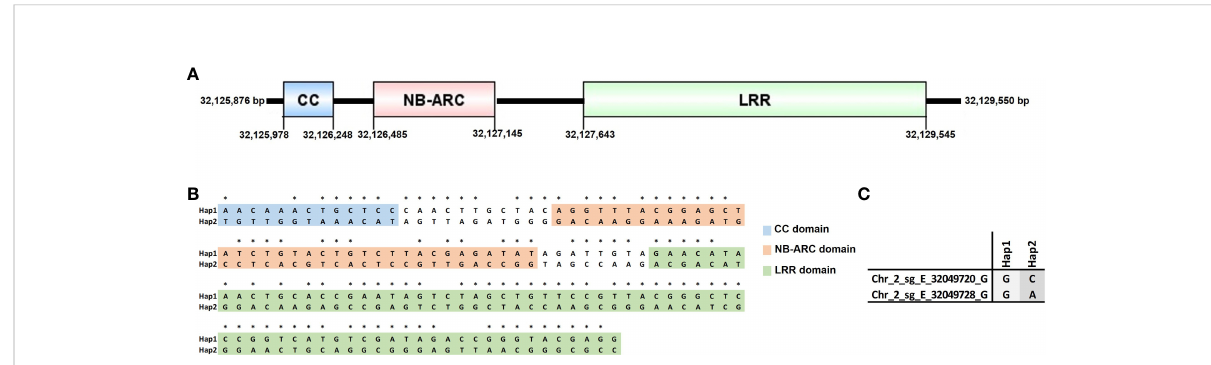
FIGURE 6 Haplotype analysis. (A) The C. arabica Et039 g010741 gene (Chr2_sg_E) and their conserved domains with respective positions in pb. (B) The 143 SNPs identi fi ed between haplotype 1 (Hap1 – Et039) and haplotype 2 (Hap2 – Caturra and Geisha); and the alleles that compose the haplotypes. The SNPs identi fi ed between Hap1 and Hap2, inserted in conserved domains, are highlighted. The position of each SNP identi fi ed in the haplotype analysis, in the C. arabica Et039 chromosome 2 eugenioides subgenome, is available in Supplementary Material 2. The 105 nsSNPs are identi fi ed with *. The amino acid change corresponding to each nsSNPs is available in Supplementary Material 3. (C) The alleles identi fi ed in the QTNs Chr_2_sg_E_32049720_G and Chr_2_sg_E_32049728_G in C . arabica Et039 (Hap1) and in Caturra e Geisha (Hap2).